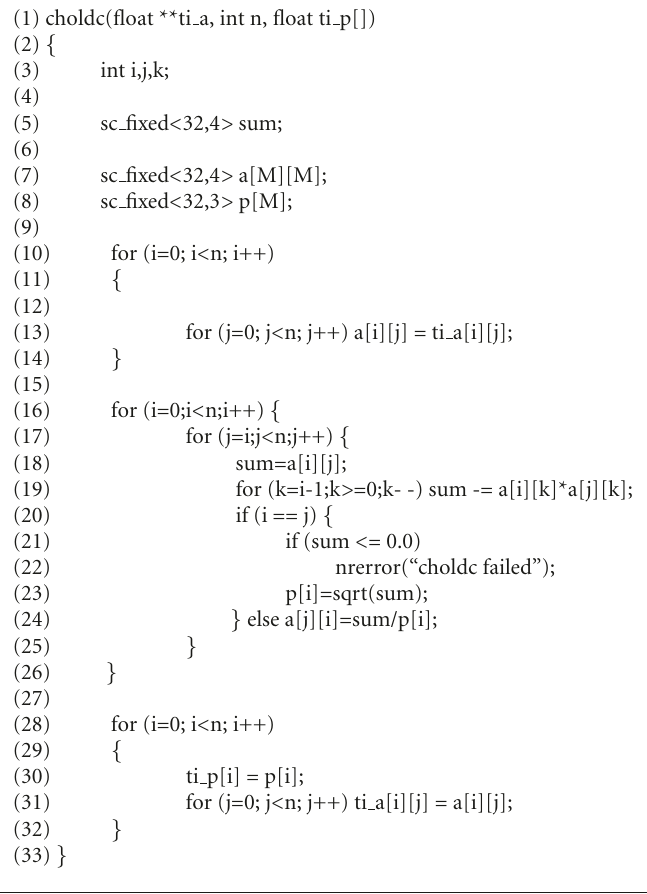
Figure 9: Fixed point implementation of Cholesky decomposition algorithm in